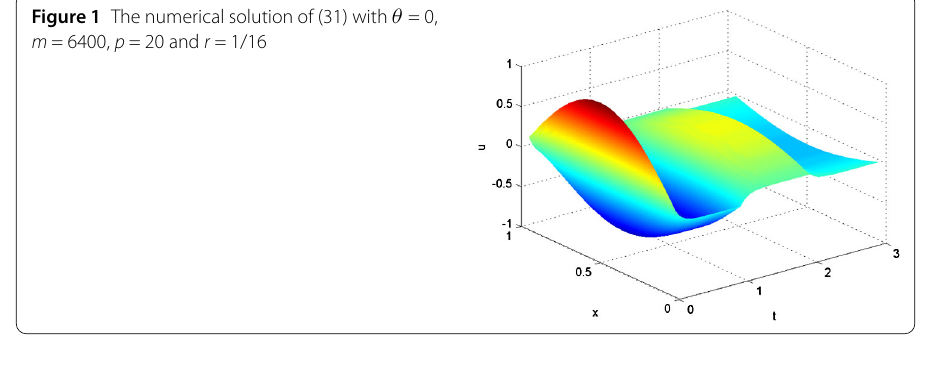
Figure 2 The numerical solution of (31) with θ = 0.5, m = 128, p = 16 and r =